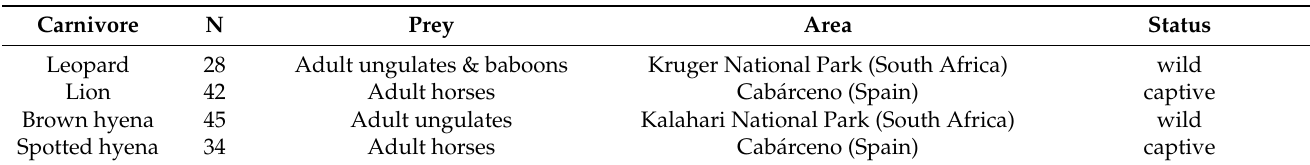
Table 1. Tooth score sample used in this